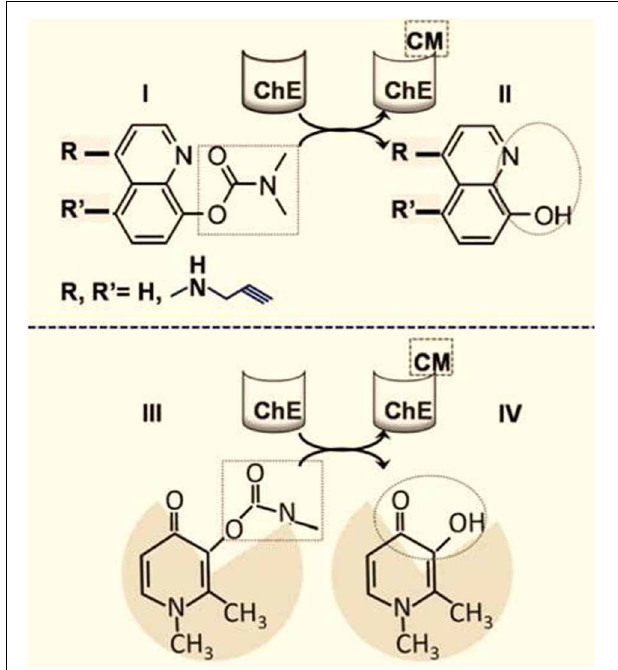
FIGURE 3 | Targeted brain iron detoxification via site-directed chelation. The rationale is based on carbamate(CM)-blocked hydoxyquinoline (HQ) (I) susceptibility to cleavage by brain choline esterase (ChE) (Zheng et al., 2009; Sohn et al., 2011). The chelating unit (II) (depicted in the dotted circle) is releasedwithinareasofthebrainwithhighChElevelsandisaccompaniedby concomitant carbamylation and inhibition of the ChE (CMChE). The HQ moietycanoptionallybemodifiedwithRgroupsattheindicatedpositions;for example, a N-propargyl group can react with and inhibit monoamine oxidase (MAO), withthereleaseofHQ-acidmethylamineandhydrogen peroxide. (III) and (IV) represent the analogous schemes (I) and (II) as applied to the hydroxy pyridin-on deferiprone instead of